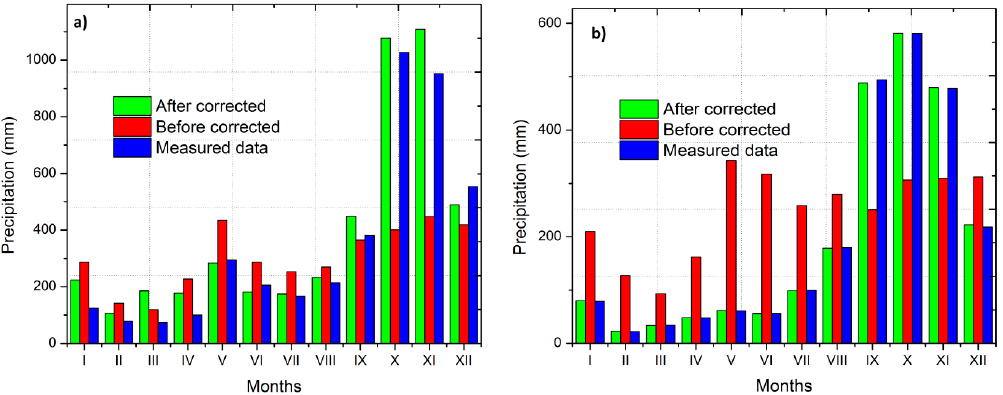
Figure 3. Before and after corrected precipitation in comparison with measured data for ( a ) Tramy station and ( b ) Danang station.